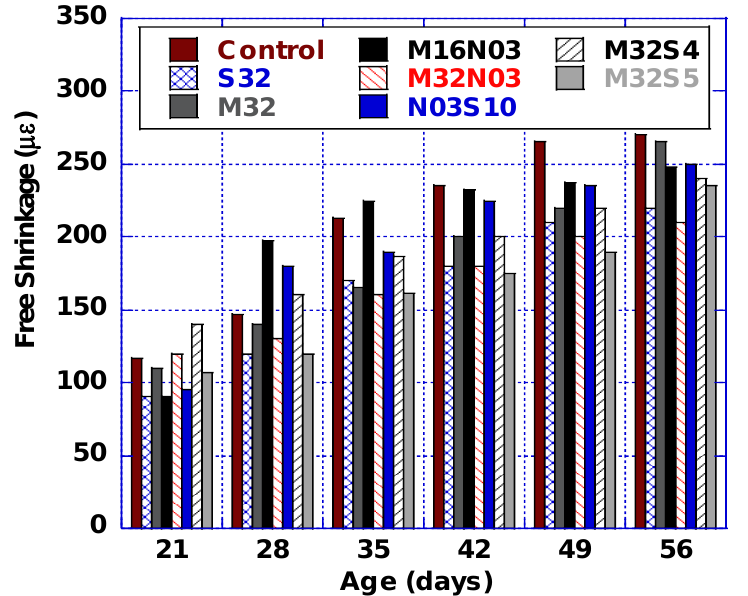
Figure 6. Free shrinkage results.